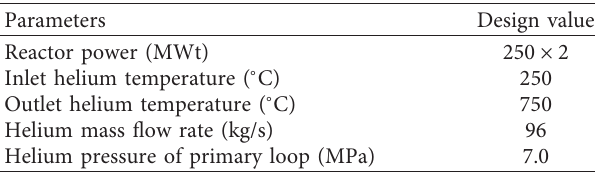
Table 7: Design parameters of the